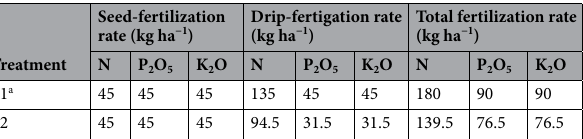
Table 2. Seed, drip and total fertilization rates in the field experiment. a F1 and F2 are the high and low fertilization rate, respectively.